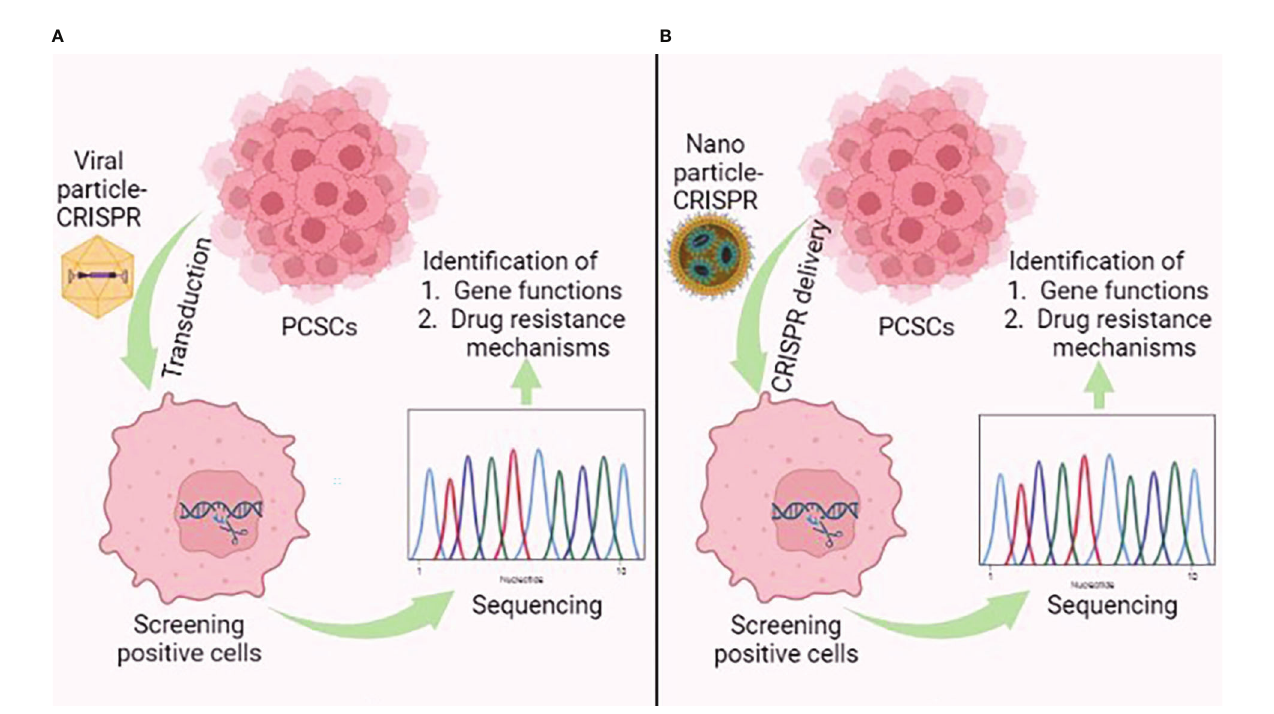
FIGURE 6 Graphical illustration showing the application of the (A) viral-mediated and (B) nanoparticle-mediated CRISPR/Cas9 delivery system in prostate cancer stem cells (PCSCs). This fi gure was created with